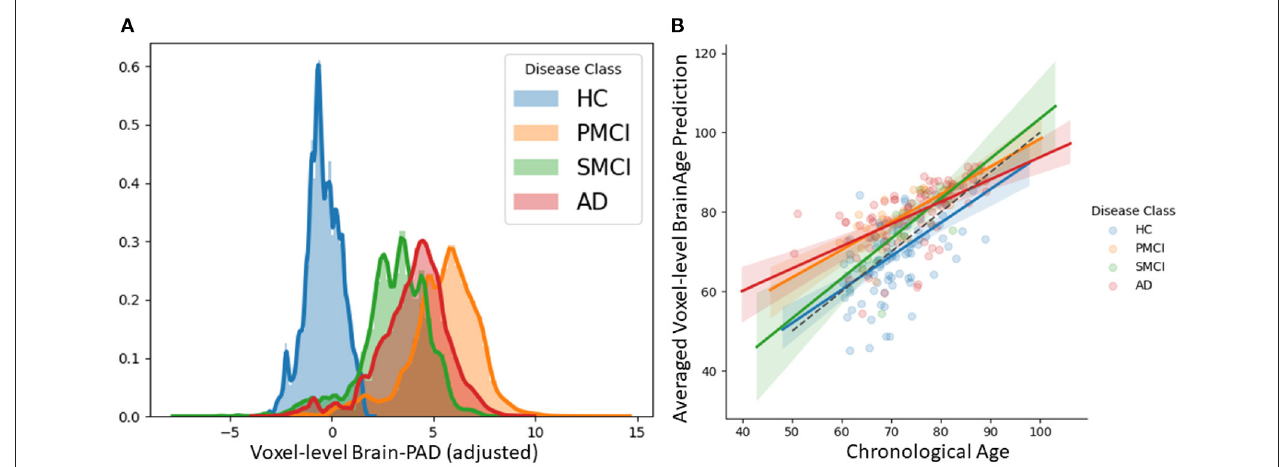
FIGURE 7 | (A) Histogram at voxel-level of brain-PAD scores of certain clinical groups from OASIS3. Brain-PAD after applying the bias-adjustment scheme is calculated for every voxel and then aggregated to the mean across all participants. Histograms in the plot are composed of the mean brain-PAD values for all voxels in the brain; (B) Adjusted global-level predictions averaged across voxels for each participant; HC, Healthy controls; sMCI, stable MCI; pMCI, progressive MCI; AD, Alzheimer’s disease.